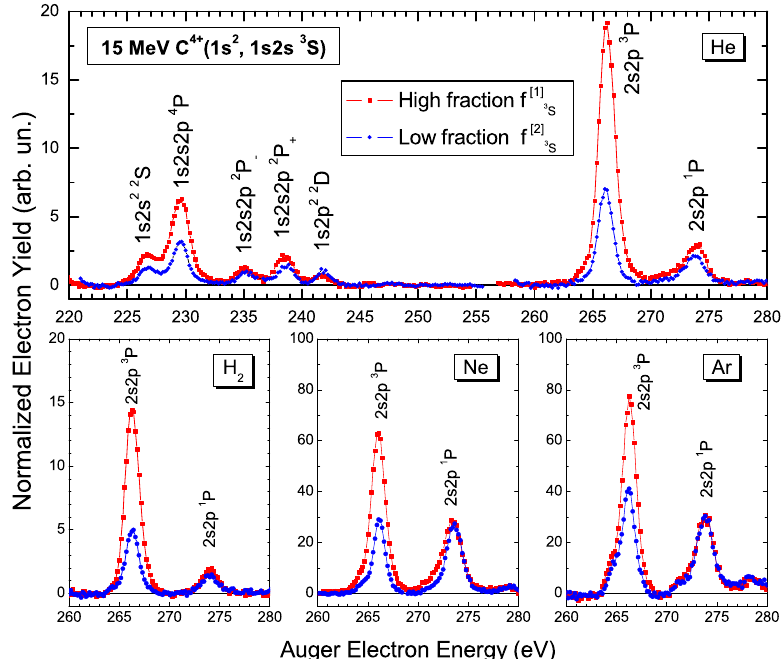
Figure 5. ( Top ) Li-like Auger spectra obtained in collisions of 15 MeV C 4 + with He targets. The red squares correspond to the mixed-state beam with higher value for the 1 s 2 s 3 S metastable fraction, while the blue dots to the lower value. The high fraction spectrum was obtained with FTS, while the low fraction with GTS. ( Bottom ) The He-like doubly excited 2 s 2 p 1,3 P states obtained in collisions with H 2 , Ne and Ar gas